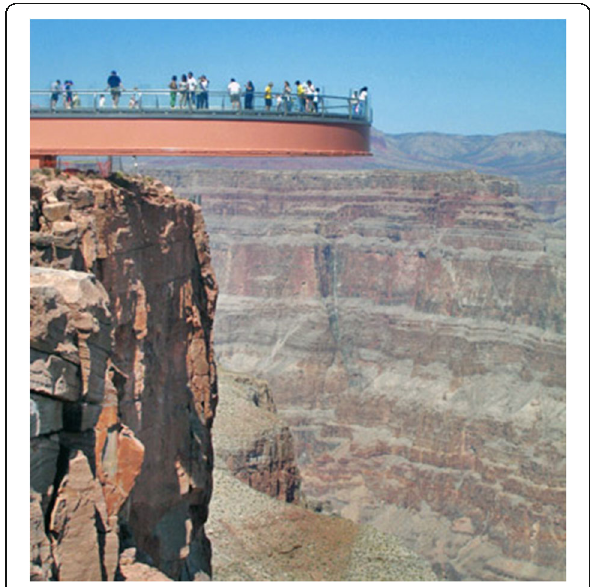
Fig. 7 Skywalk from outside ledge. [Attribution: Complexsimplellc